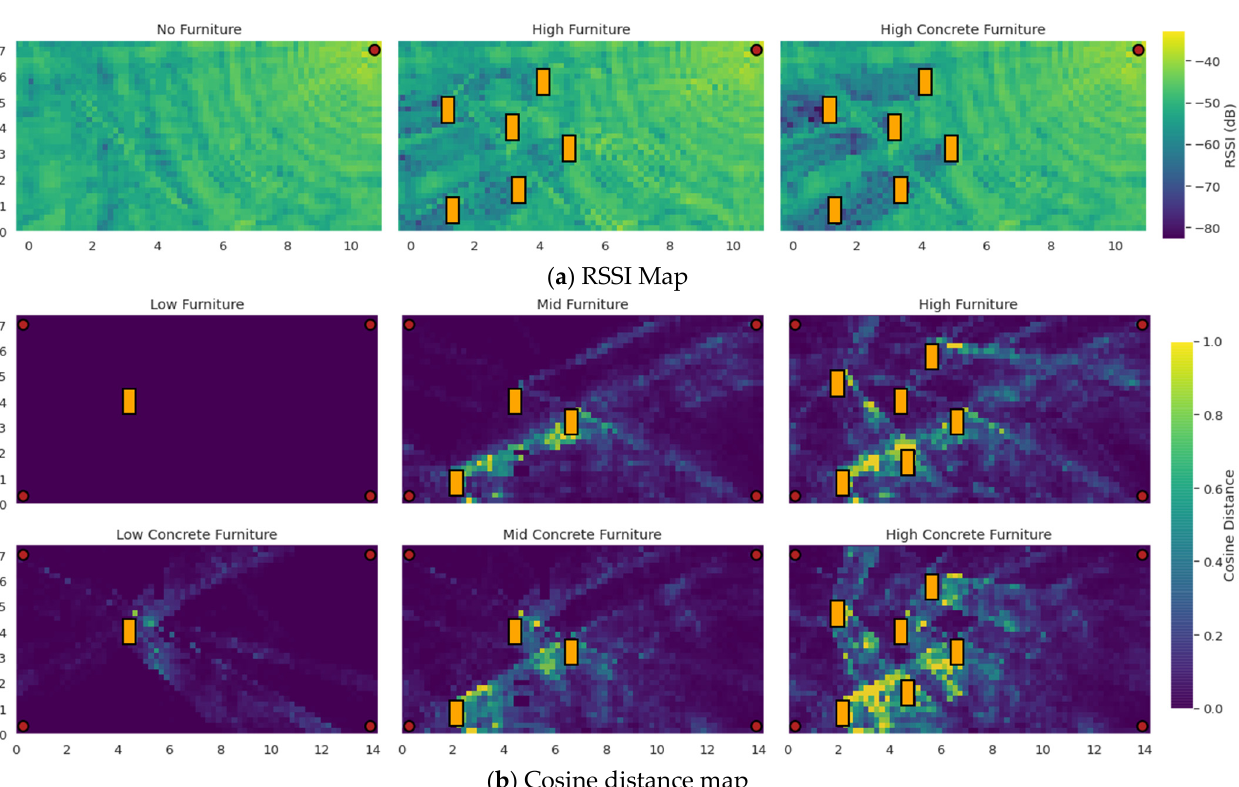
Figure 5. Visualization of the four room configurations.